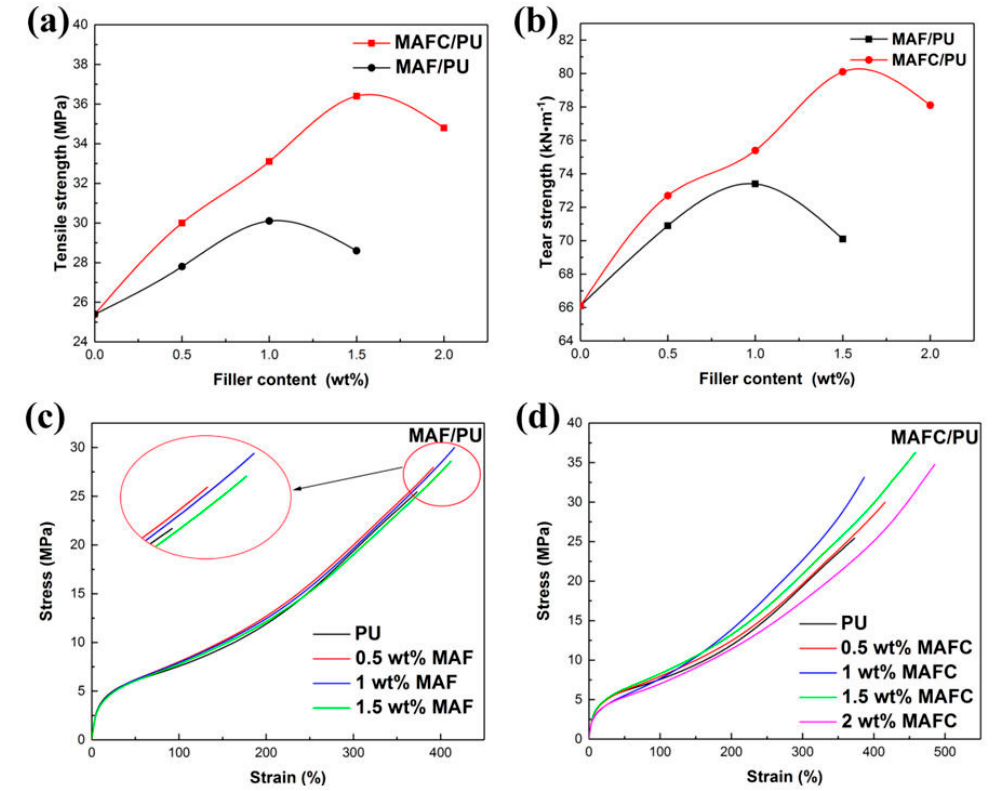
Figure 6. Mechanical properties of the composites: ( a ) tensile strength, ( b ) tear strength of MAF / polyurethane (PU) and MAFC / PU, ( c ) tensile stress-strain curve of MAF / PU, and ( d ) tensile stress-strain curve of MAFC / PU.